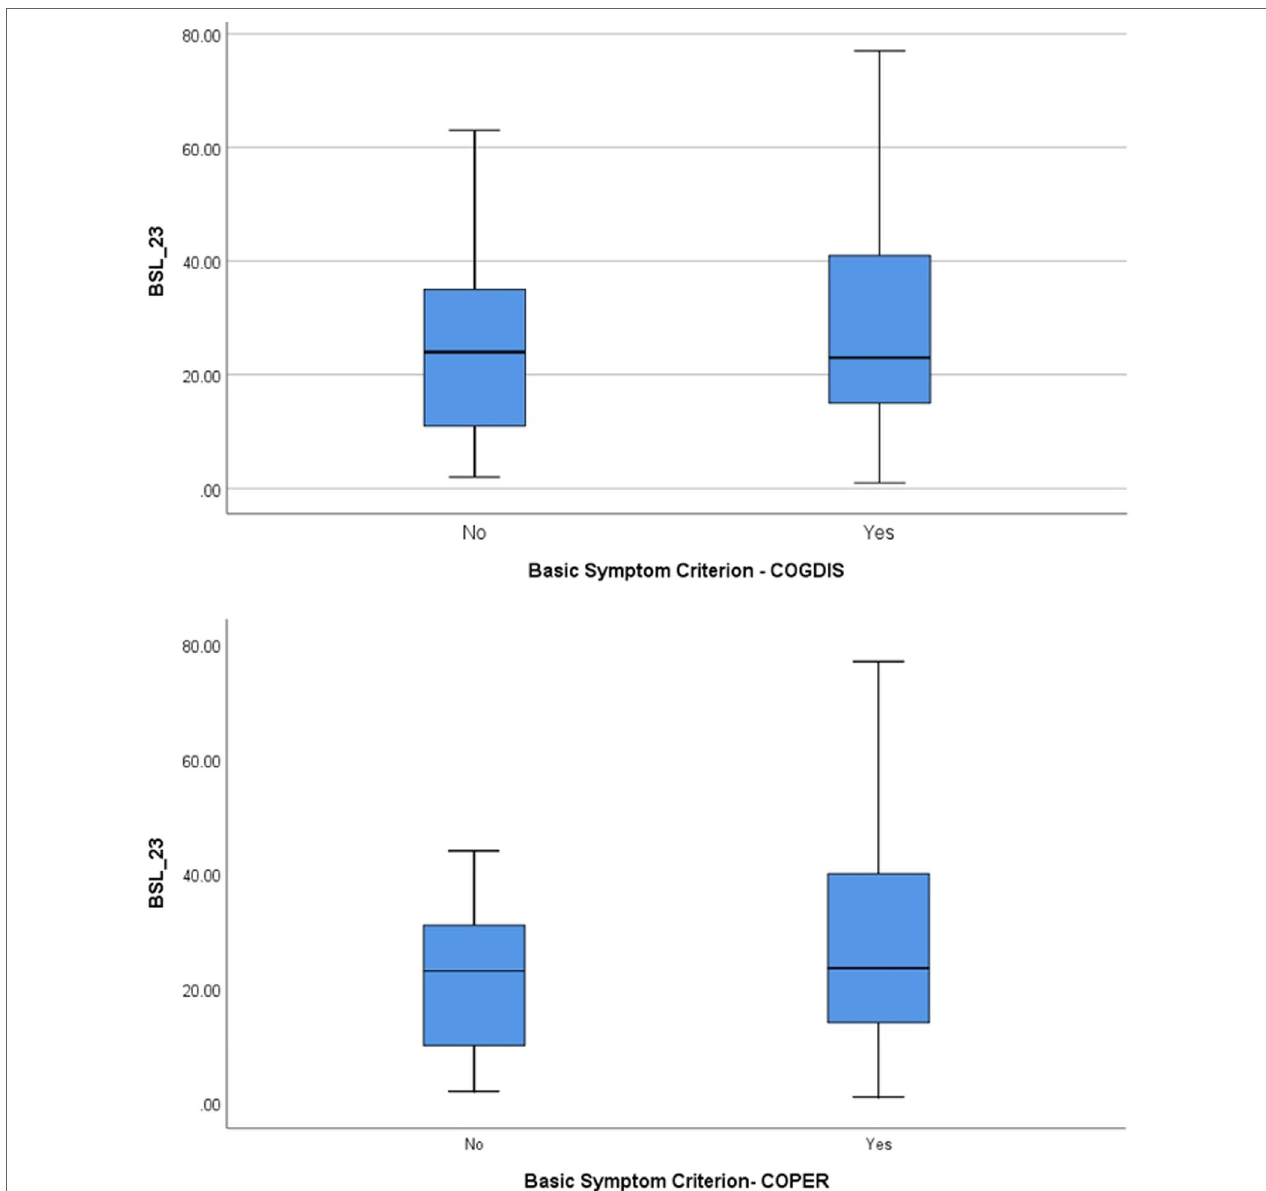
FIgURe 1 | Borderline symptom list (BSL) score separated according to the presence of basic symptom criteria COPER and COGDIS.